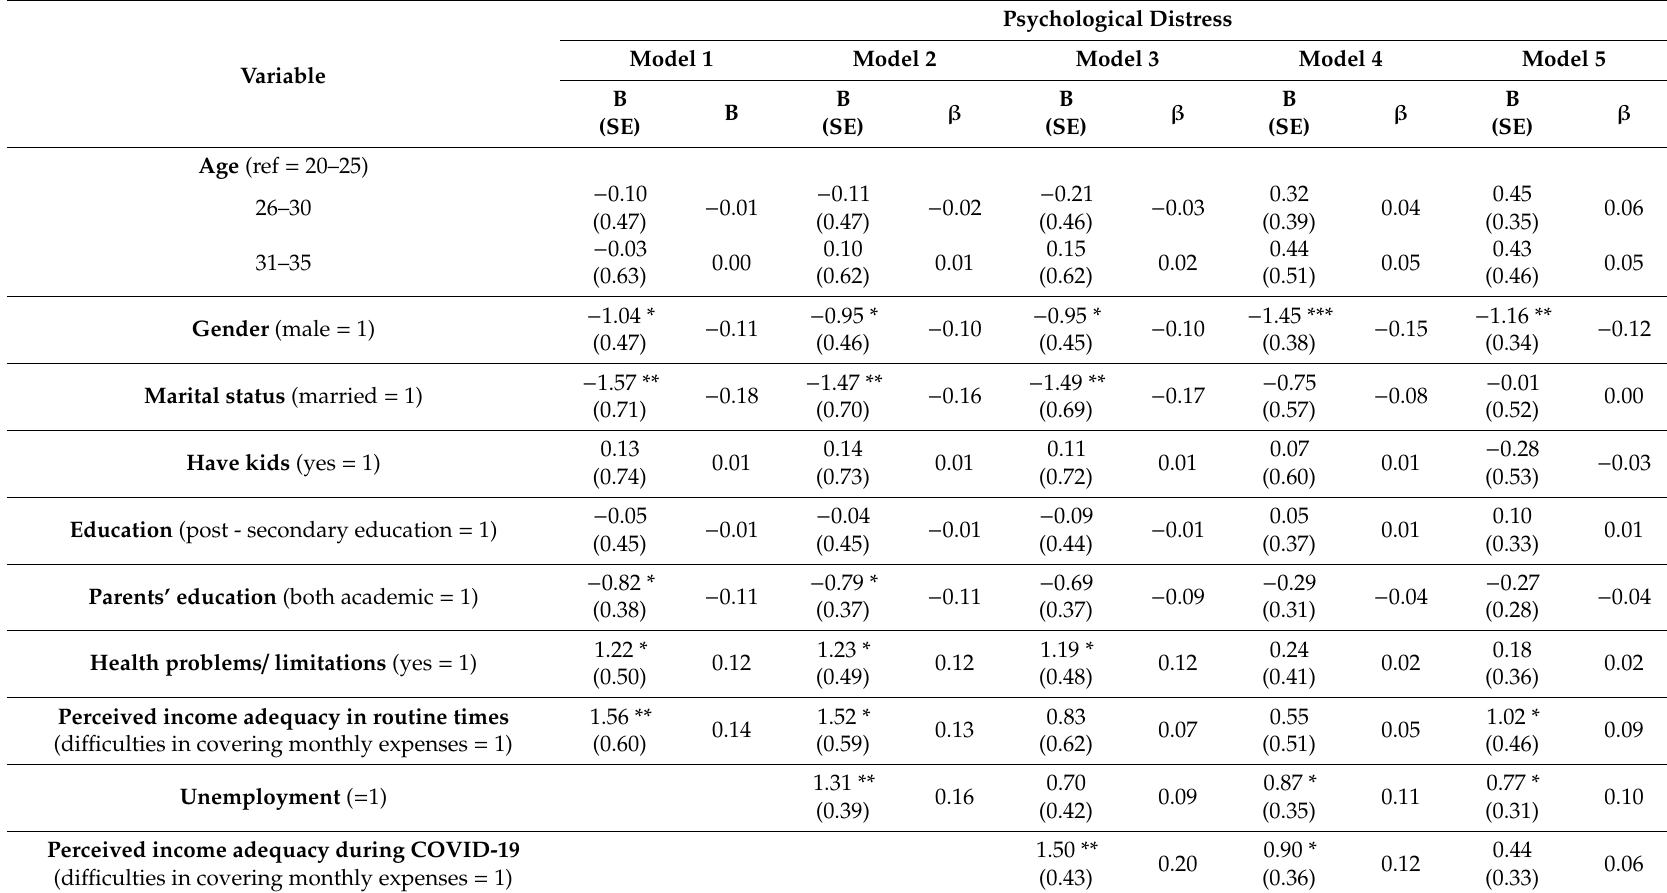
Table 3. Hierarchical multiple regression analysis for predicting PD